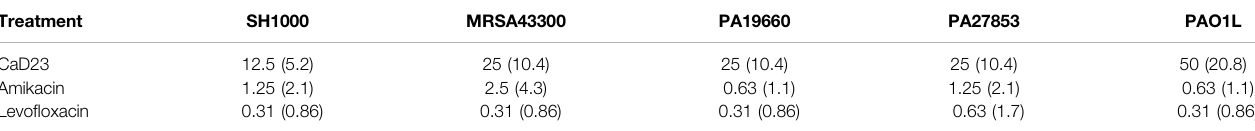
TABLE1| Minimuminhibitoryconcentration(MIC)ofCaD23,amikacinandlevo fl oxacinagainstmethicillin-sensitive Staphylococcusaureus (SH1000),methicillin-resistant S. aureus (ATCCMRSA43300), Pseudomonasaeruginosa ATCCPA19660(cytotoxicstrain),ATCCPA27853(invasivestrain)andPAO1L(invasivestrain).TheMICvalueis expressed in μ g/ml (and μ M in bracket).